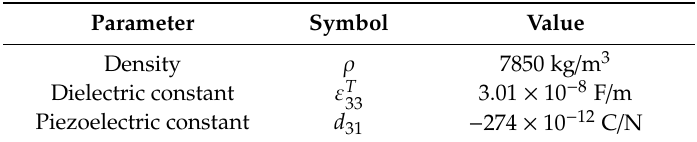
Table 2. Material coe ffi cients of the beam and the adhesive layer.